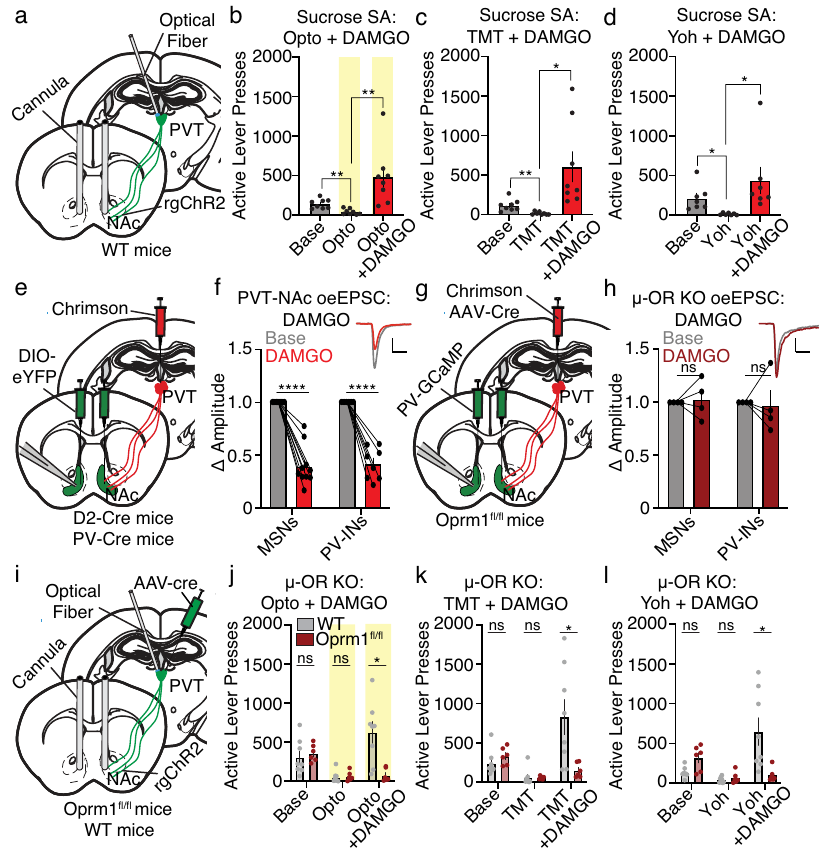
Fig. 6 | PVT → NAc-dependent suppression of reward seeking is gated by presynaptic µ -opioid receptors.a Surgicalstrategyforoptogenetic manipulation of PVT → NAc neurons and intra-NAc DAMGO infusions. b – d Intra-NAc infusion of DAMGO prevented the suppression of sucrose self-administration caused by PVT → NAc stimulation ( b ), TMT ( c ), and yohimbine ( d ) (Opto: n =8 mice/group; one-way ANOVA, F 2,21 =9.33, P =0.001; planned two-tailed t -tests: base vs. opto P <0.01,optovs.DAMGO+opto P <0.01;TMT: n =8mice/group;one-wayANOVA, F 2,21 =8.02, P =0.003; planned t -tests: base vs. TMT P <0.01, TMT vs. DAMGO+ TMT P =0.02; yohimbine: n =7 mice/group; one-way ANOVA, F 2,18 =4.26, P =0.03; planned t -tests: base vs. yohimbine P =0.02, yohimbine vs. DAMGO+yohimbine P <0.05). e Surgical strategy for patch-clamp electrophysiology. f Example elec- trophysiological waveforms (scale: 50pA/50ms) and grouped data reveal that DAMGO reduced PVT → NAc MSN and PVT → NAc PV-IN oeEPSC amplitudes (MSNs: n =10 cells, 6 mice; PV-INs: n =8 cells, 5 mice; repeated-measures two-way ANOVA, effect of DAMGO: F 1,16 =210.9, P <0.0001; Sidak ’ s post-hoc: P -values<0.001). g Surgical strategyforknockoutofPVT µ -ORswithpatch-clampelectrophysiology. h Example electrophysiological waveforms (scale: 50pA/50ms) and grouped data reveal that